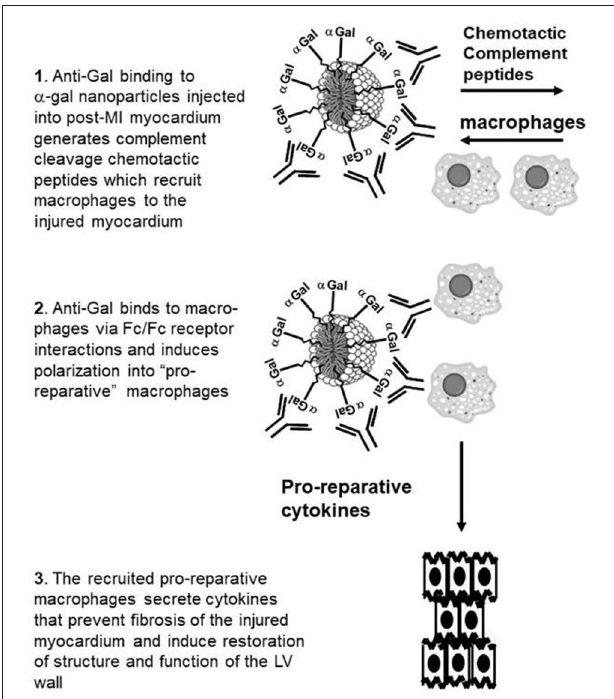
FIGURE 1 | Hypothesis on post-MI myocardial repair by intramyocardial injection of α -gal nanoparticles: Stage 1 . Anti-Gal binding to injected α -gal nanoparticles activates the complement system to generate chemotactic peptides that recruit macrophages. Stage 2 . Recruited macrophages bind via Fc-receptors the Fc “tail” of anti-Gal coating the α -gal nanoparticles and are induced to polarize into macrophages secreting pro-reparative cytokines. Stage 3 . The pro-reparative cytokines induce structure and function restoration of the injured myocardium.